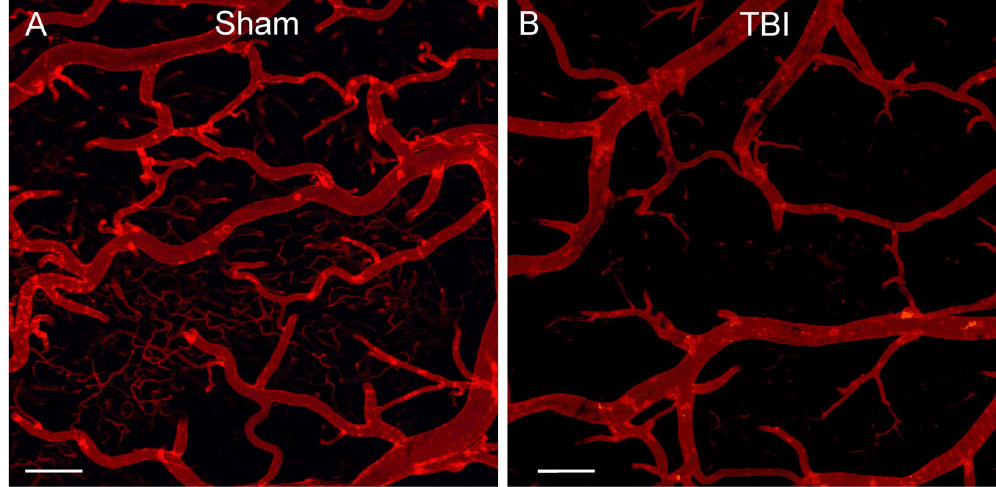
Figure 2. Confocal images of vessel painted vasculature at the perilesional region. ( A ) Sham animal exhibited uniform staining of large, intermediate and small vessels at the perimeter of the craniotomy site. ( B ) The vessels of a TBI animal demonstrate marked sparsity in vessel numbers and dramatic loss of small vessels adjacent to the injury site. Cal bar = 200